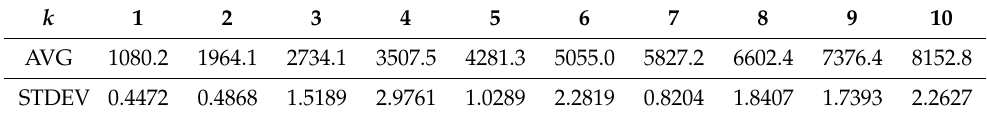
Table 3. Average and standard deviation of running time of the proposed algorithm (in